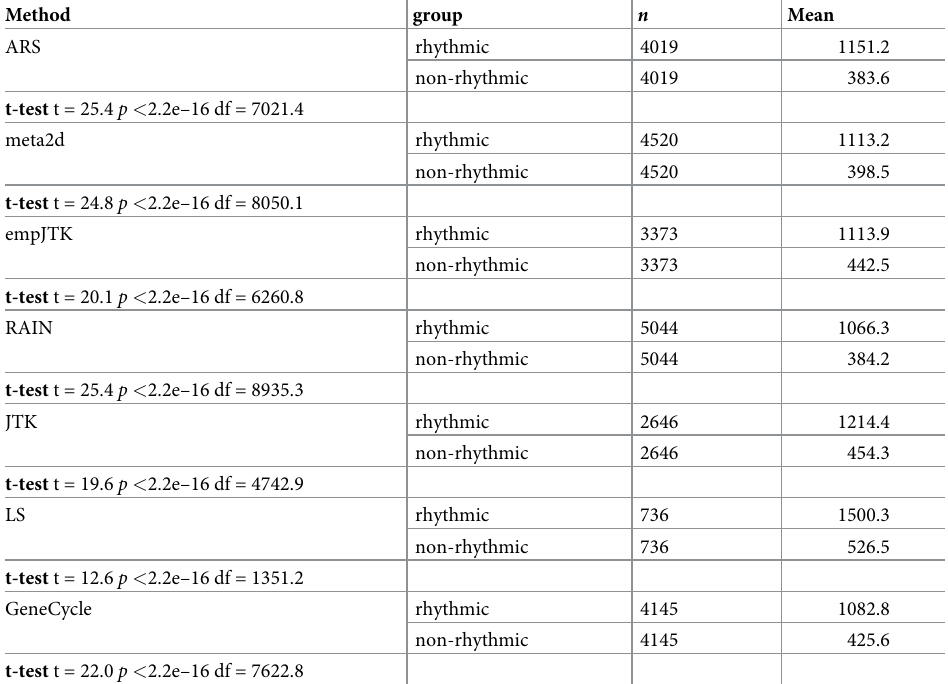
Table 2. t-test comparing the expression levels between rhythmic ( p -value � 0.005) and non-rhythmic genes (ran- domly chosen same number of genes among those with p -value > 0.01), in mouse liver dataset (microarray).